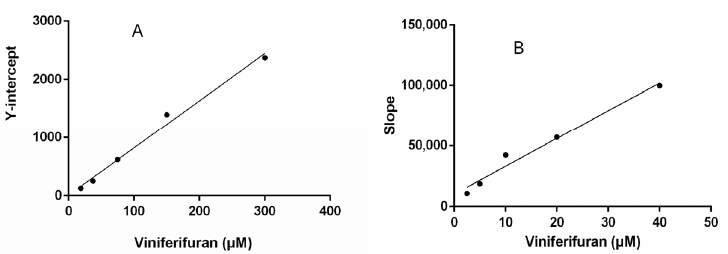
Figure 5. ( A ) Secondary plots of the Y-intercept of the Lineweaver–Burk plots vs. viniferifuran. ( B ) Secondary plots of the slopes of the Lineweaver–Burk plots vs. viniferifuran. Each point is the mean of three independent determinations.